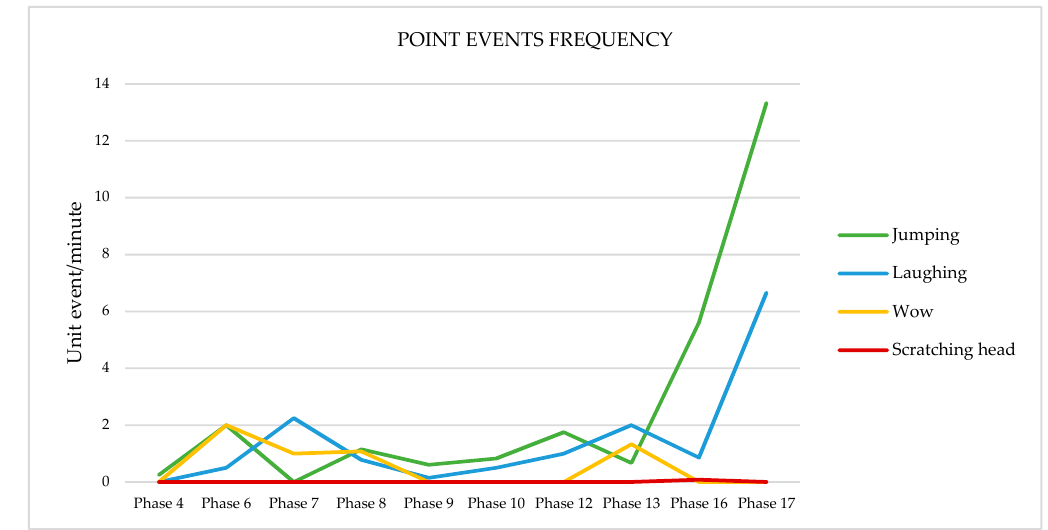
Figure 7. The figure shows the frequency of the four point events in a minute range.